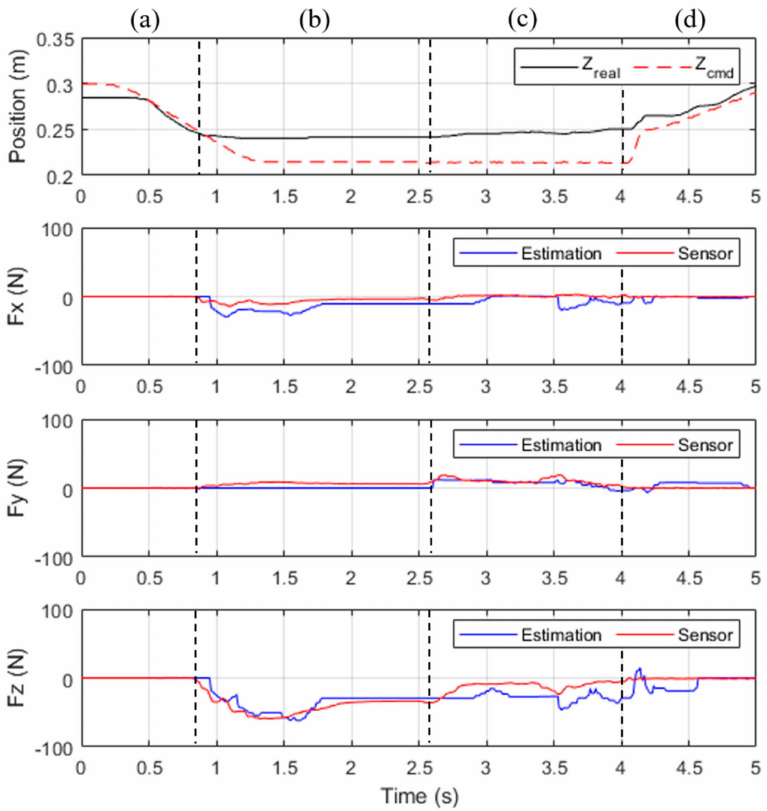
Figure 17. Results of wiping experiment.